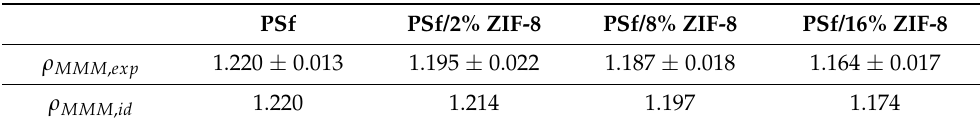
Table 1. Density values measured in pure PSf and MMMs and comparison with ideal additive values Equation